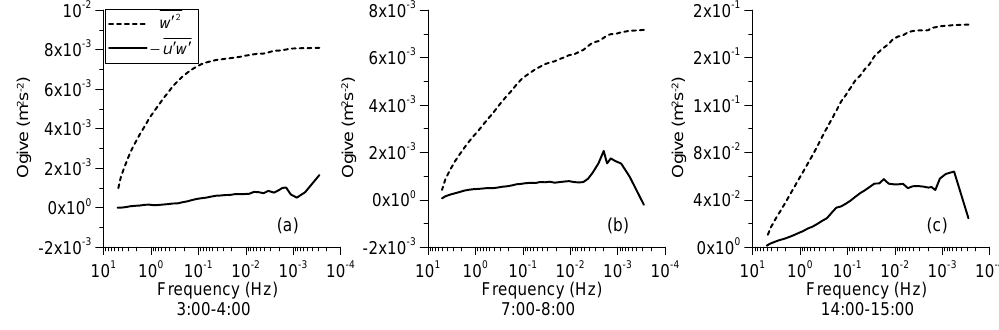
Figure 7. Variation of ogive functions of w (cid:48) 2 and − u (cid:48) w (cid:48) with frequency at height 3.08m for the three time frames in NSPCE.